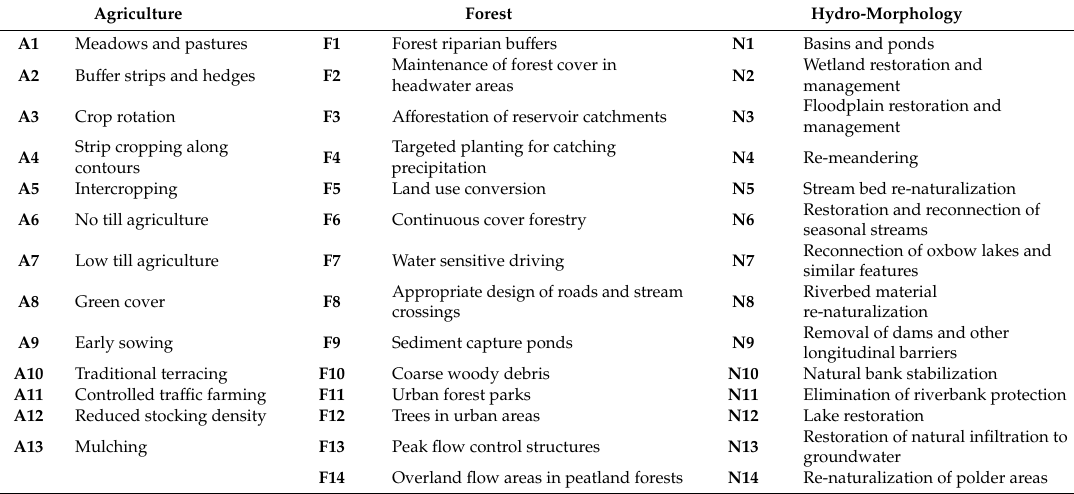
project [29]. Short-names in bold are the ones displayed in the final